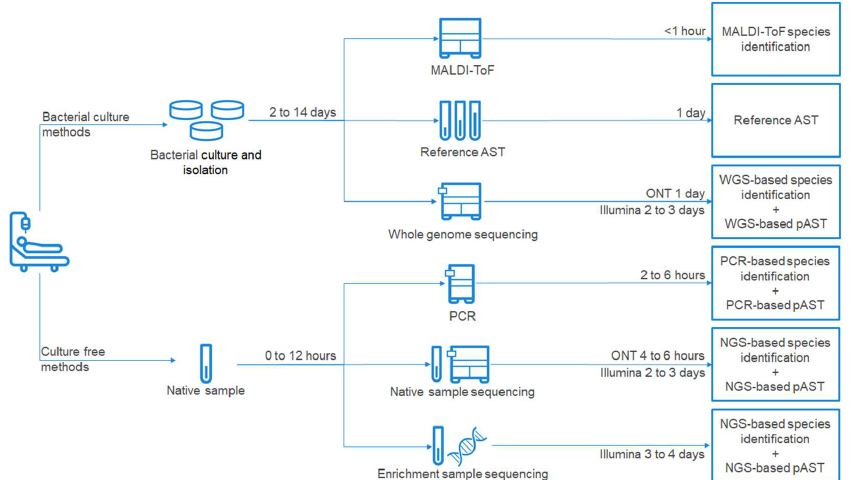
Figure 1. Diagram of possible routes to (predictive) AST and microbial identification. The diagram includes standard of care as well as novel methods and lists approximate times needed to obtain diagnosis.